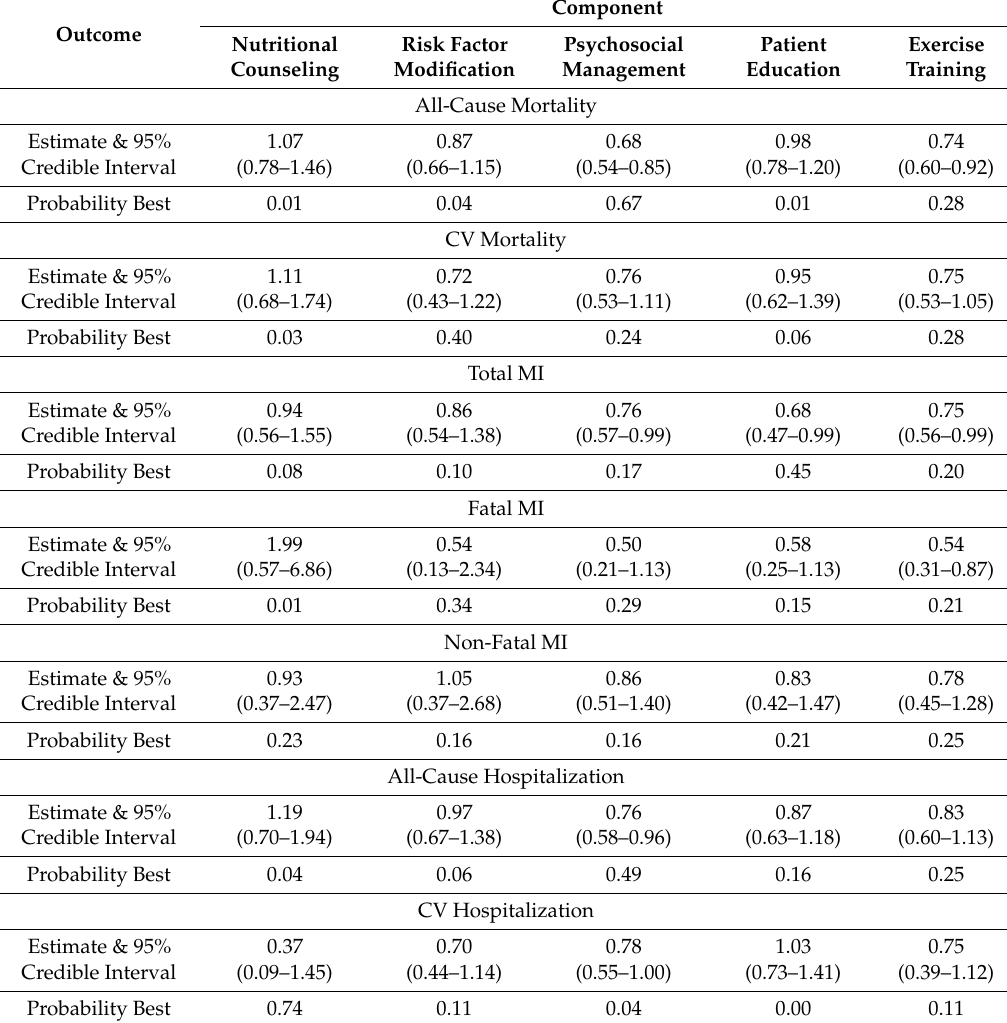
Table 3. Estimates for Effects of Core Components and Probability of Having Largest Effect for Main Effects Model by Outcome.